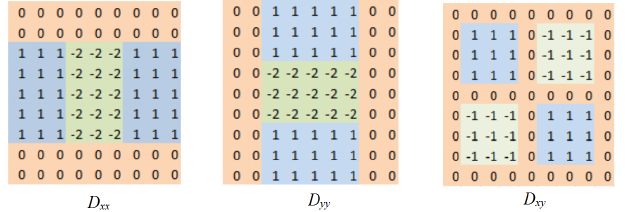
Figure 6. Three filters used in interest point detection for horizontal, vertical and diagonal direction. D xx is the horizontal filter, D yy is the vertical filter and D xy is used to detect diagonal interest points. Each filter is performed on every pixel in a CU with